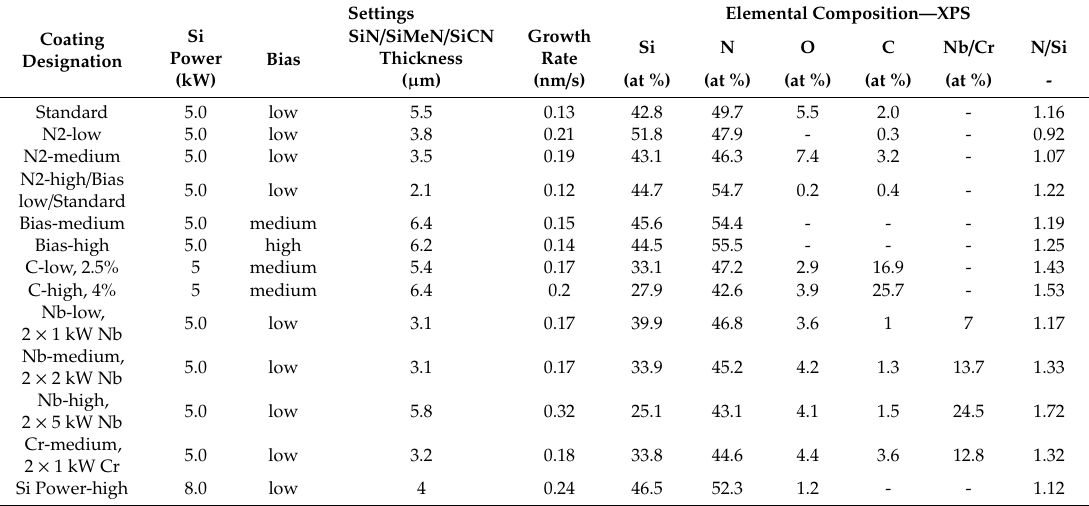
Table 2. Deposition settings, coating thicknesses, growth rates, and